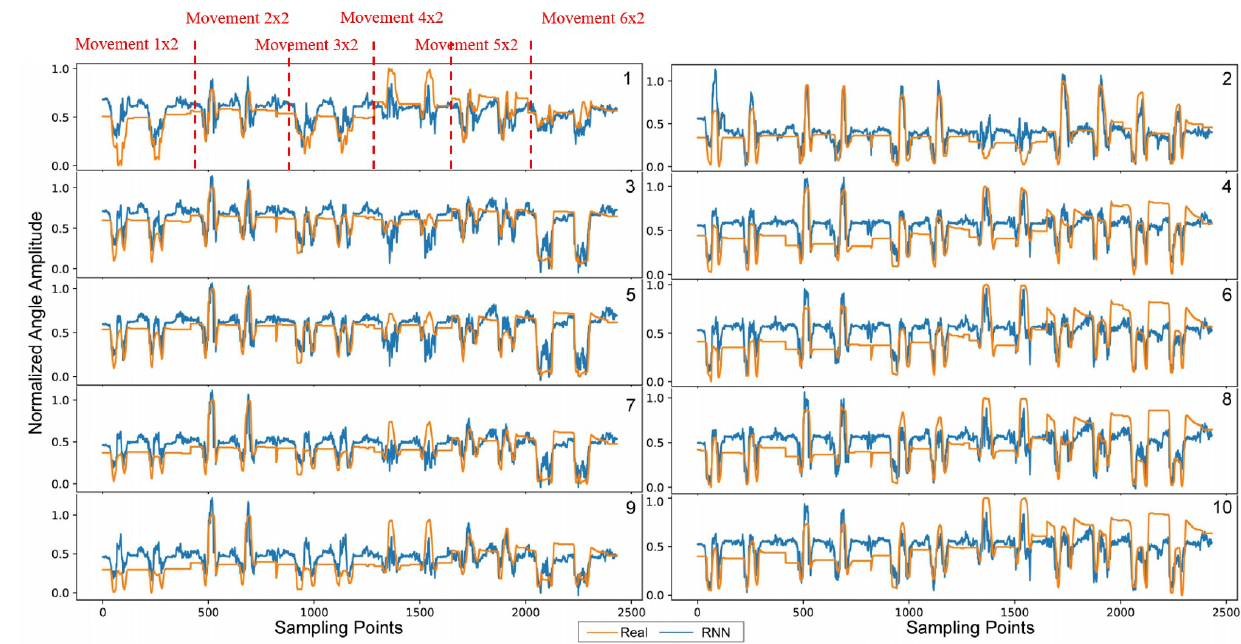
Figure 9. The continuous amplitudes of real and predicted joint angles using RNN. There are 10 subfigures for 5 fingers (i.e., two joints per finger as depicted in Figure 2), and each subfigure denotes the result of a finger joint, where the x-axis represents the sampling point index and the y-axis denotes normalized joint angles. Each movement was performed twice, and thus every two peaks or valleys represents a movement; i.e., 6 grasping movements were characterized by 12 peaks/valleys in each subfigure. The annotations of subfigure 1 indicate the division of 6 movements with 2